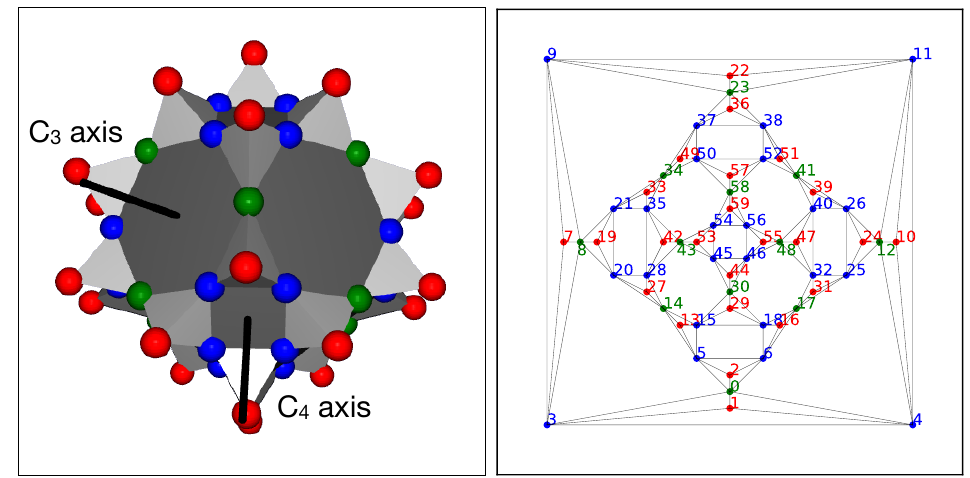
Figure 1: Left: Ball-and-stick drawing of the SOD60 molecule with a 4-fold and a 3-fold symmetry axis indicated. Right: Projection on the plane (Schlegel diagram) using the square orientation. The enumeration of the sites is the result of applying the Cuthill-McKee compression. Equivalent sites are drawn in the same